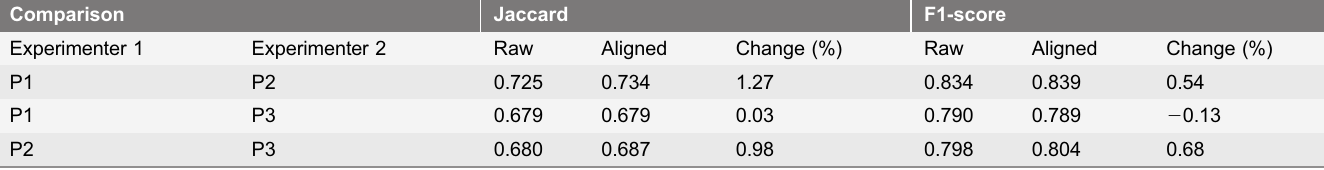
Table 1. Comparison of manual focus selection by two different experimenters across 21 images a .